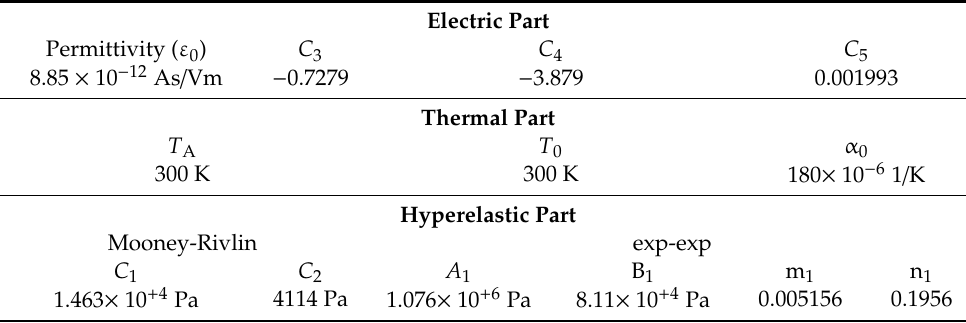
Table 1. The material parameters adopted for the electro-hyperelastic model. Electric Part